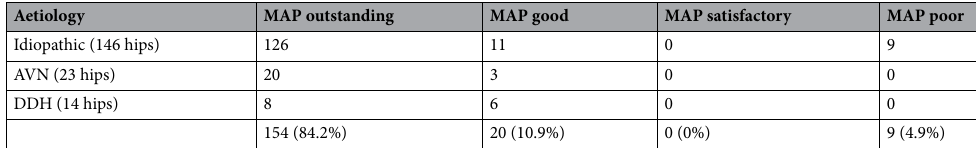
Table 3. Clinical results by the modified Merle d’Aubigne and Postel’s (MAP) grading, with consideration of the aetiology of degenerative changes. AVN avascular necrosis of the femoral head, DDH developmental dysplasia of the hip.